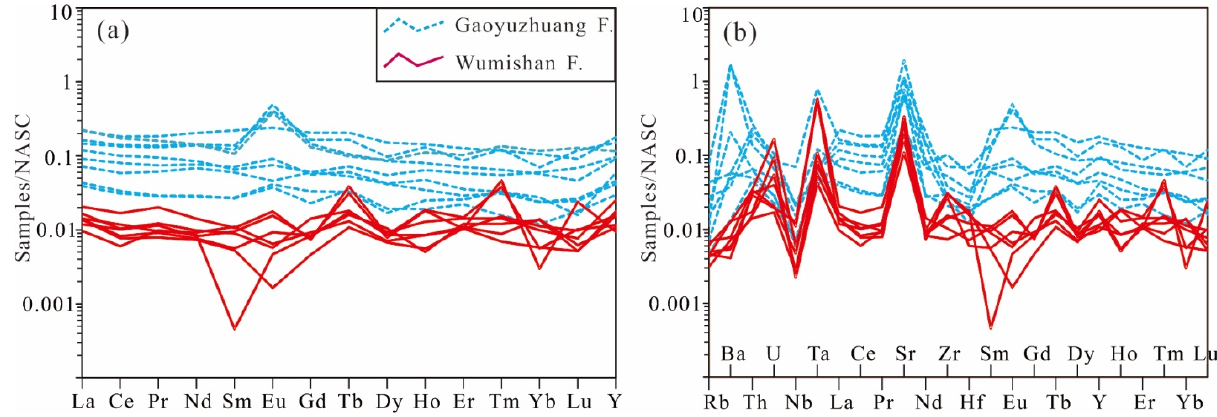
Figure 7. ( a ) NASC-normalized REE patterns and ( b ) NASC-normalized spider diagrams of incom- patible elements for the carbonate rocks from the Gaoyuzhuang and Wumishan Formations.